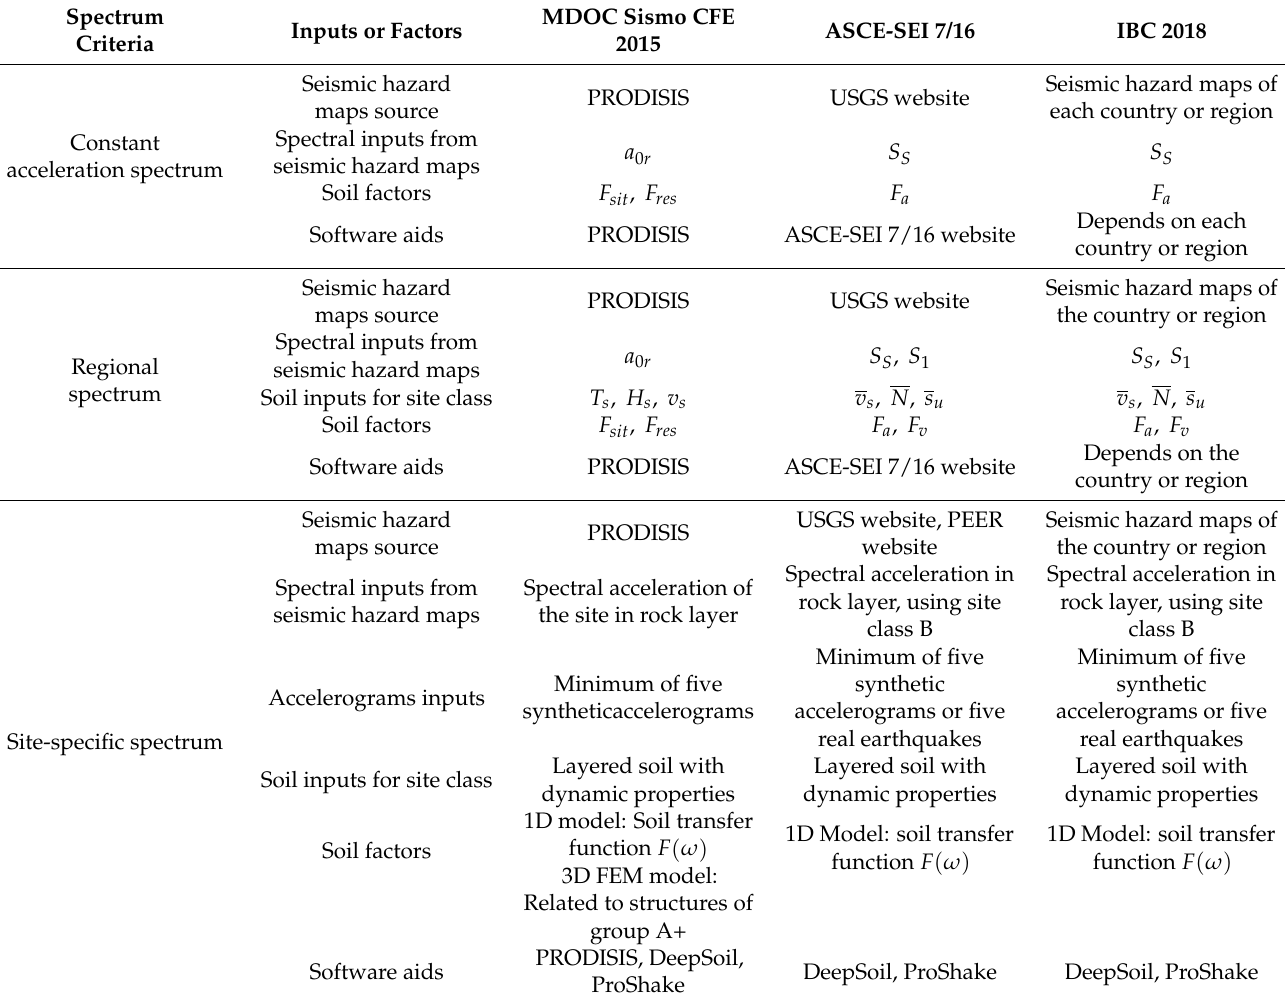
Table 9. Seismic response spectra criteria and comparison between